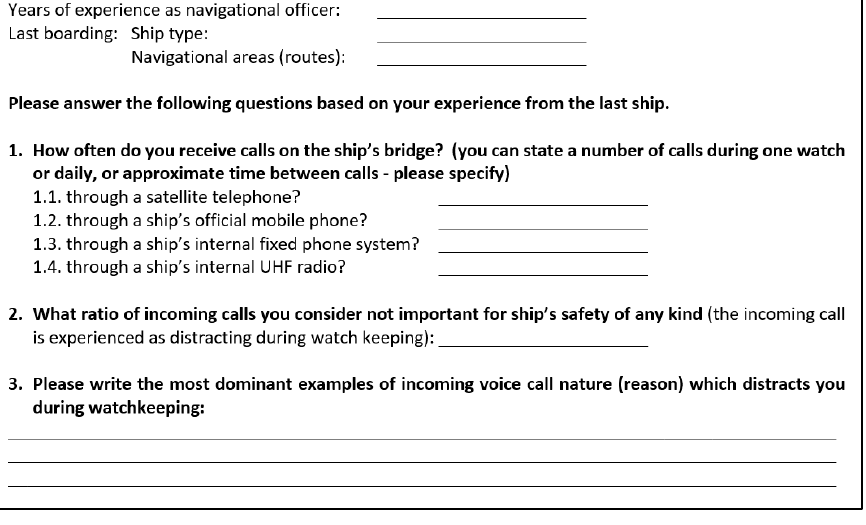
Figure 1. The survey questions.